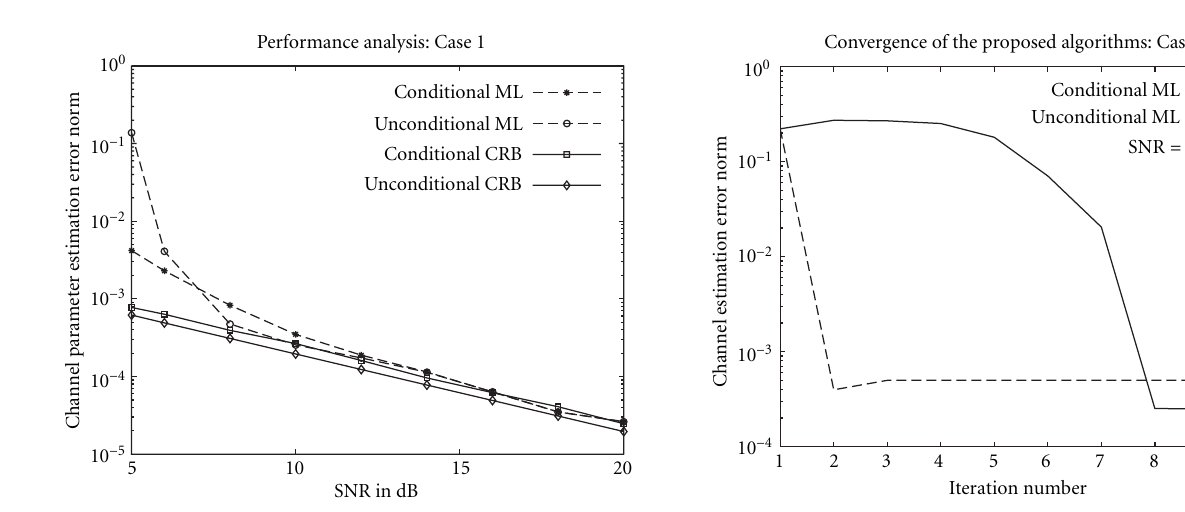
Figure 6: Case 1: Convergence of the channel matrix.